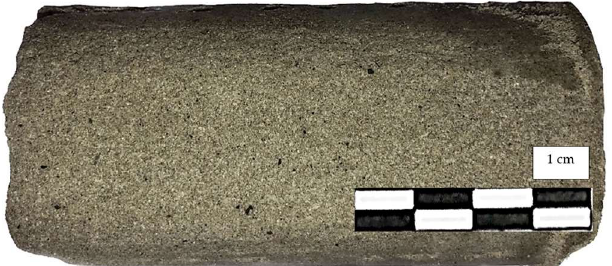
Figure 2. General view of the frozen sand 3 sample with pore methane hydrate (W = 14%; S h = 26%; T = −6 °С).